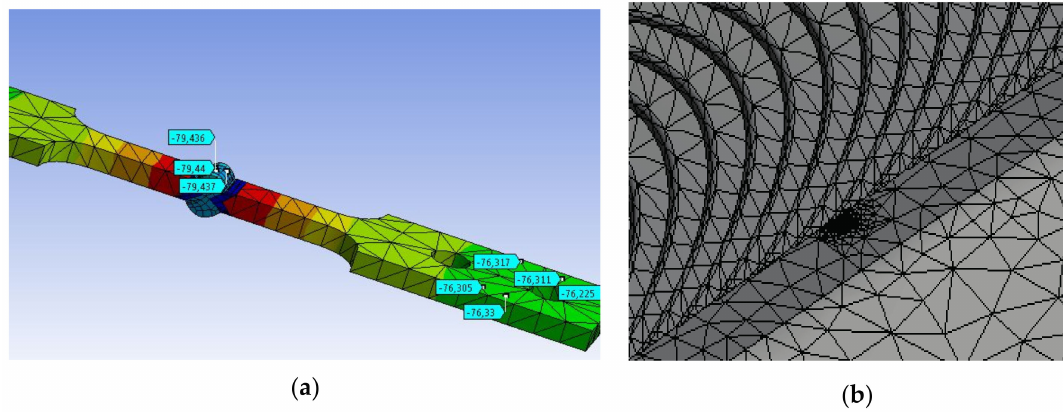
Figure 5. ( a ) The temperature profile for the cooling cycle post welding and residual stress C = 5 mm, ( b ) semi-elliptical crack on welding and plane generated for the finite element